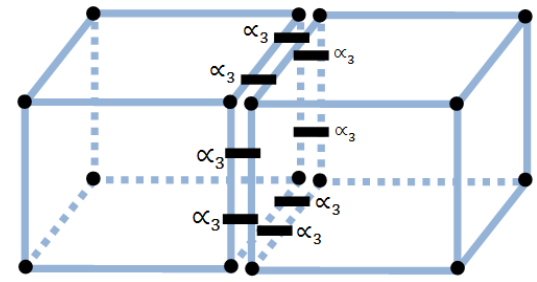
Figure 4 . Example of gathering two cubes along their faces by